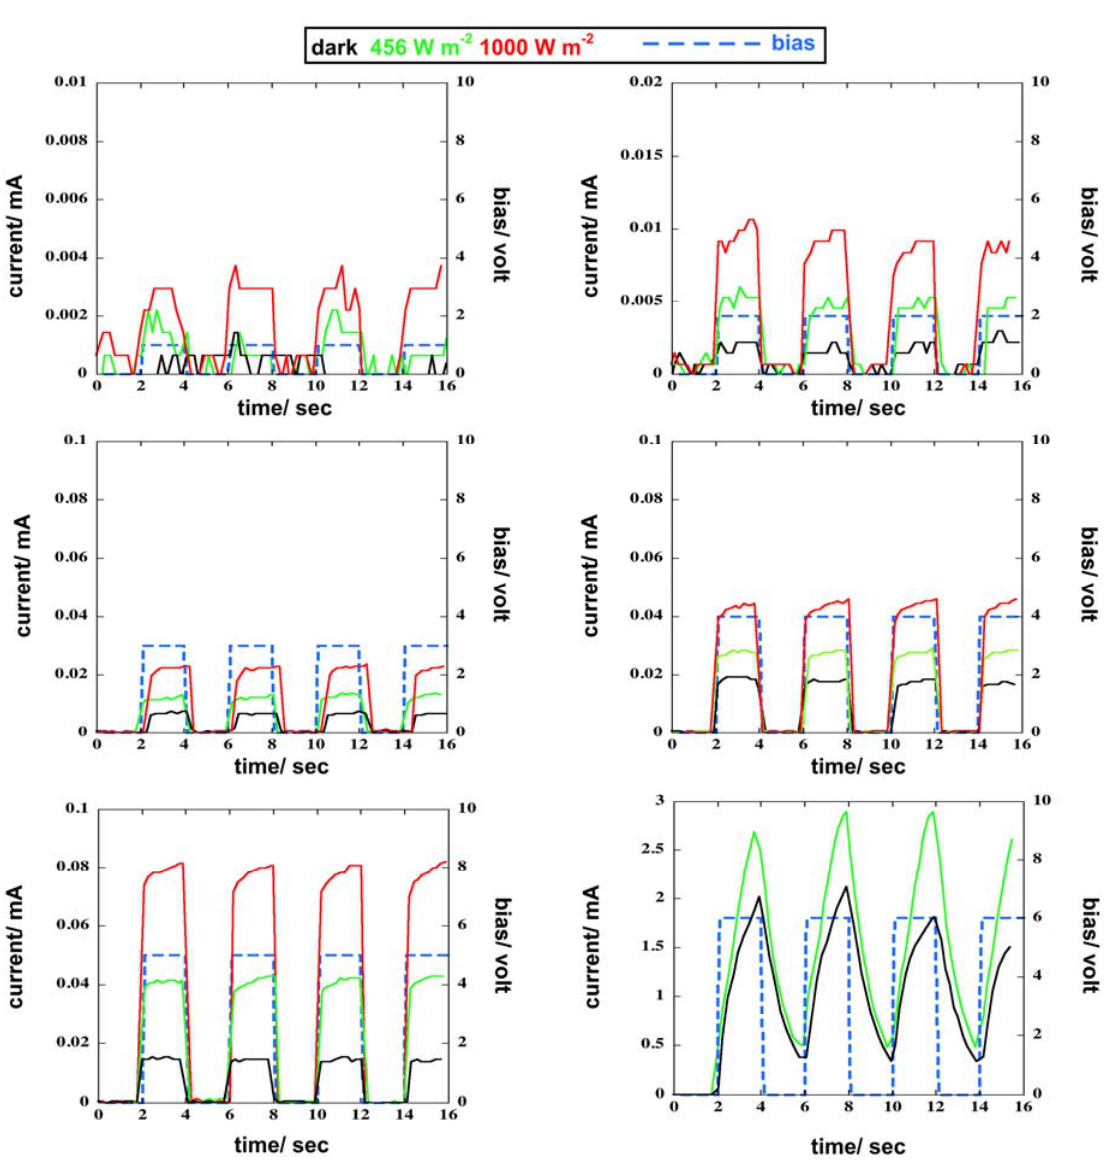
Figure 8. The response of the current of the photoresponsive device vs. forward ‐ biased voltage pulse.